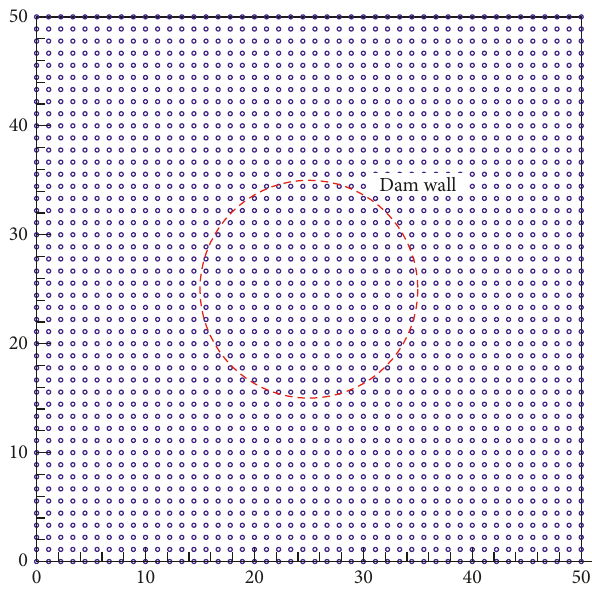
3s, t 5s, and t 7.2 (cid:29) (cid:29) (cid:29)